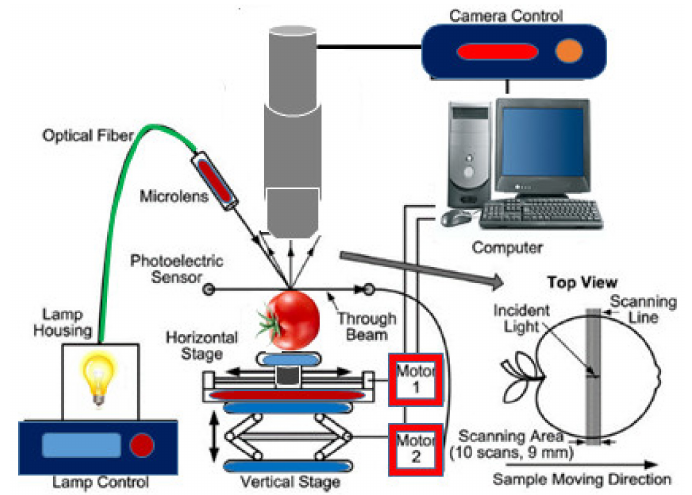
Figure 6. Hyperspectral imaging system for acquiring spatially resolved scattering images from a fruit sample (modified from